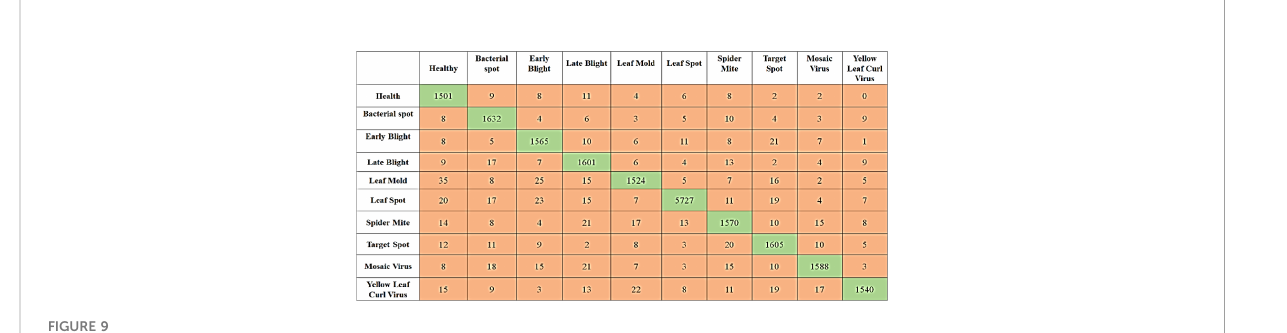
FIGURE 9 Proposed model confusion matrix for Tomato plant disease classi fi cation.